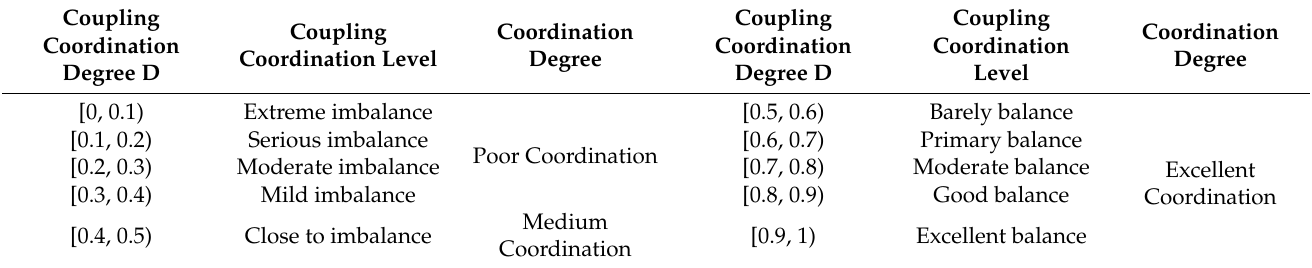
Table 3. Classification standard of coupling coordination level.